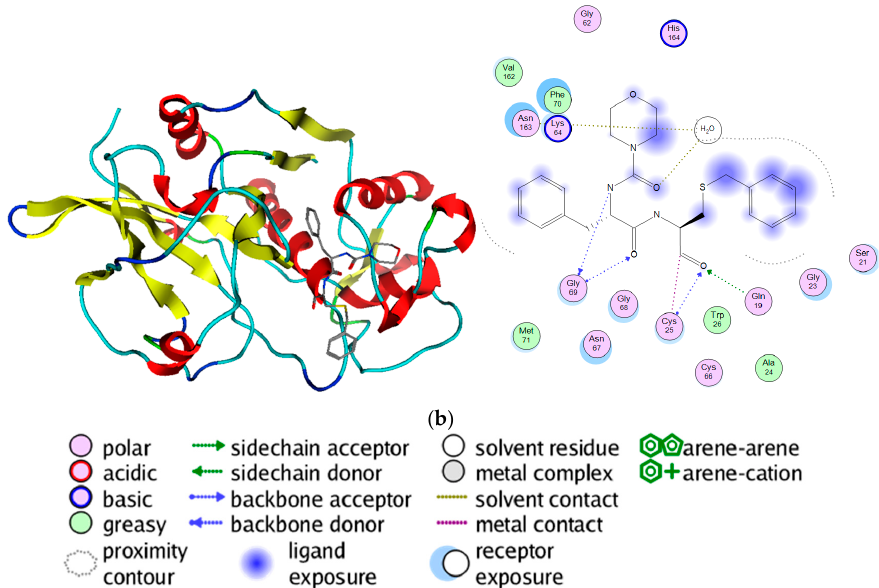
Figure 1. Cathepsin K and S targets. 3D structures with the corresponding 2D binding mode of bound ligands (E64 and C4P respectively) are shown for both targets ( a ) K and ( b ) S, respectively. PDB [33] codes are 1ATK [34], 1NQC [35]. The amino acid residues in 2D graph are colo-coded according to MOE defult scheme, green (hydrophobic), pink (polar, acidic, and/or basic) with arrows indicating the hydrogen bonding interactions, green arrow (sidechain donor or acceptor) and blue arrow (backbone donor or acceptor).